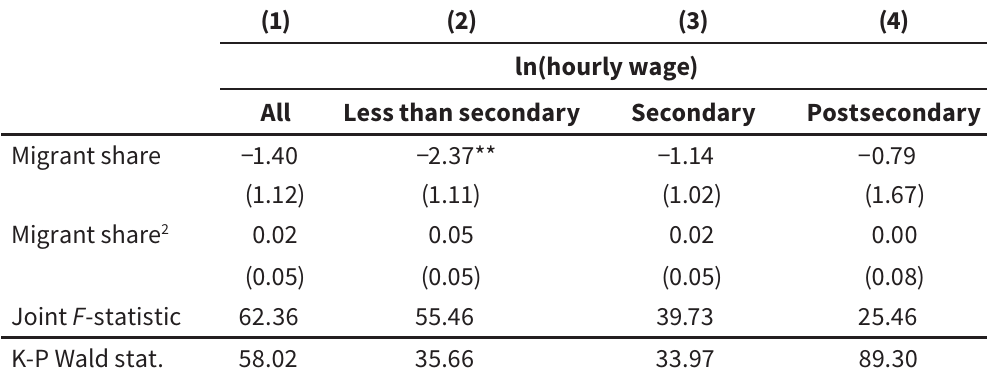
2SLS estimates with migrant share